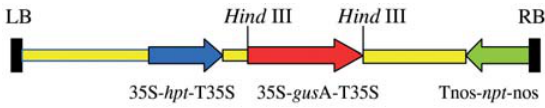
Figure 1 - Schematic diagram of